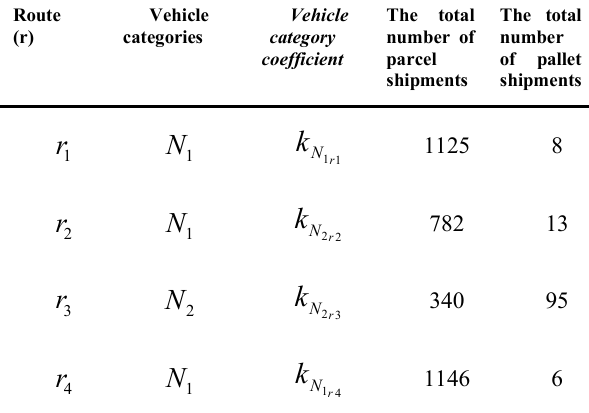
Table 3. Individual data used as an example